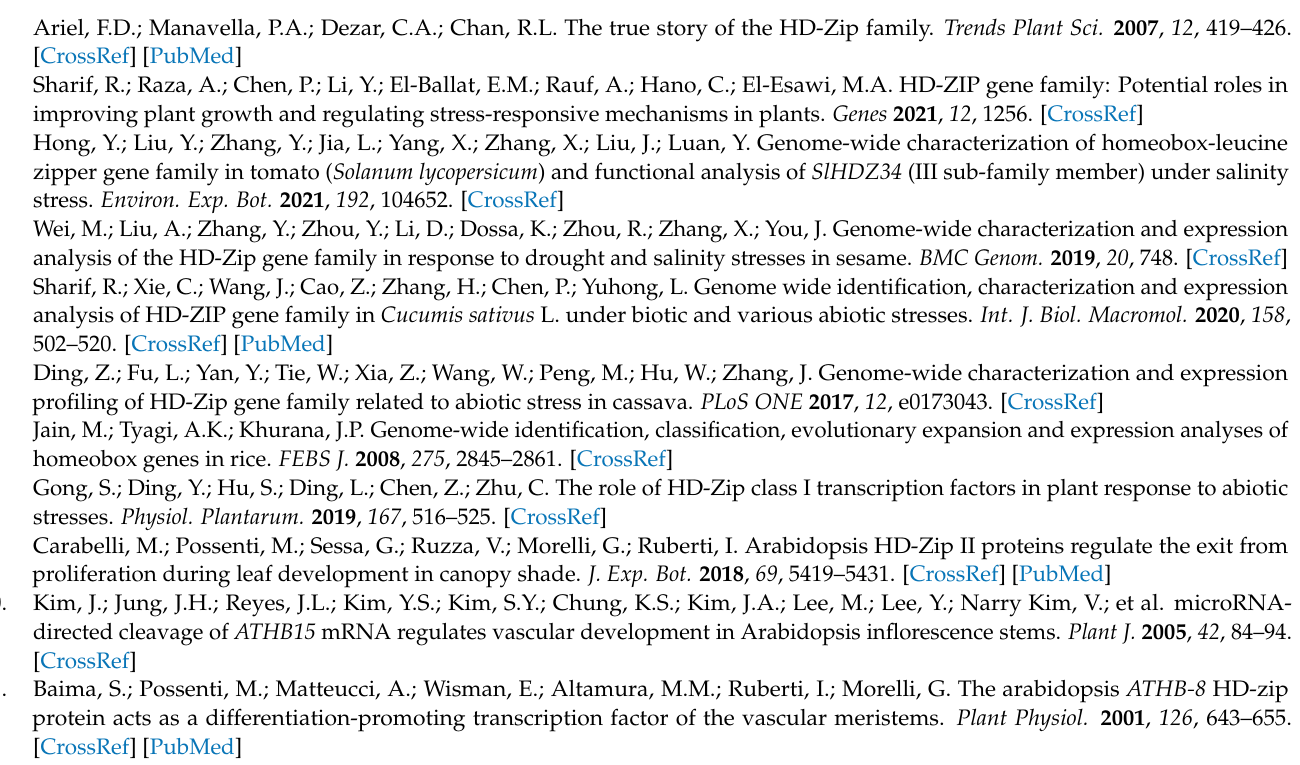
Table S2. Syntenic relationships of ClHDZs in watermelon genome; Table S3. Syntenic relationships of the HD-ZIP genes between